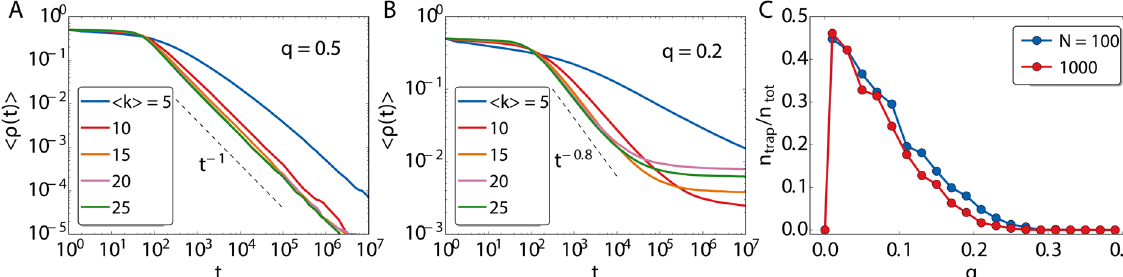
Figure 6. Average fraction of active links as a function of time for different values of 〈 k 〉 with q = 0.5 ( A ) and q = 0.2 ( B ). The system size is N = 1000 and the curves are averaged over 1000 simulations. In ( C ) the fraction of trapped realizations n trap / n tot starting from random initial conditions averaged over 1000 realizations for two network sizes and with 〈 k 〉 =